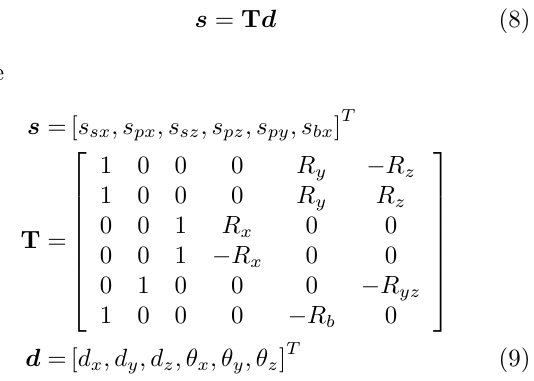
Figure 5: Locations of motion sensors